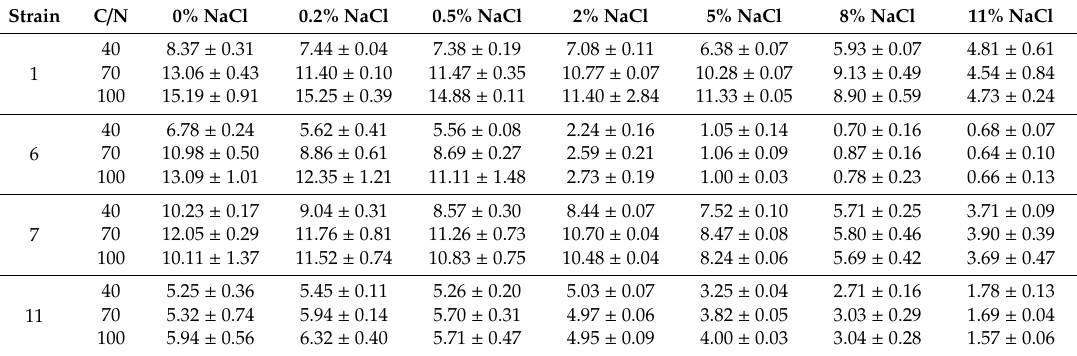
Table 5. The e ff ect of di ff erent osmolarity levels on biomass yield in strains C. infirmominiatum